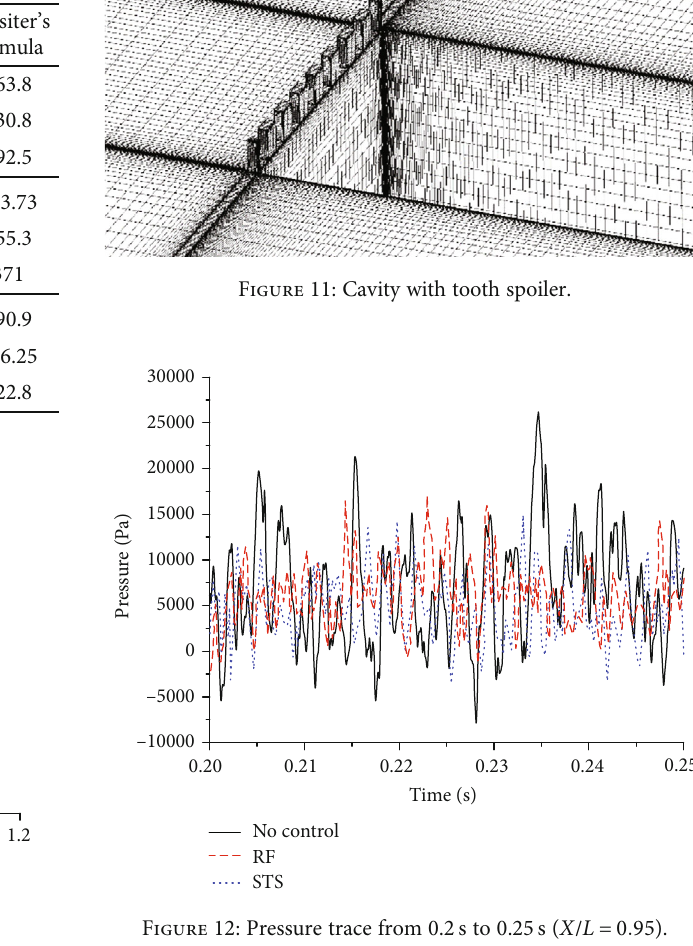
Figure 9: Comparison of OASPL distribution between CAA.